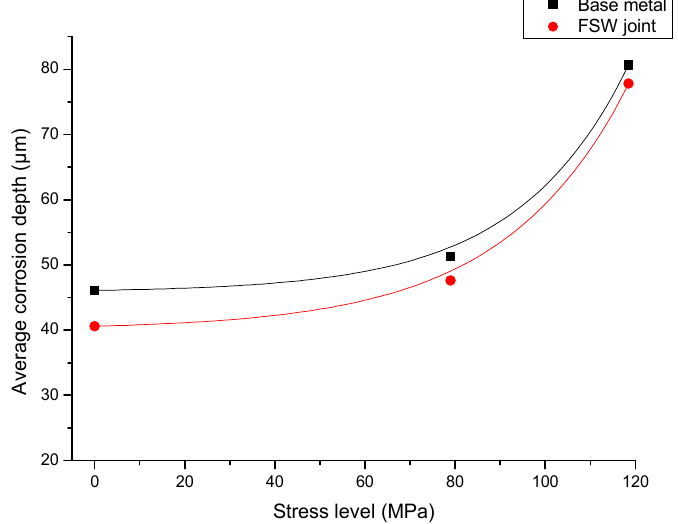
Figure 18. Variation of the average corrosion depth ( µ m) with level of applied stress (MPa) for the two chosen specimens of aluminum alloy 2219. Duration of exposure to environment is 48 h.